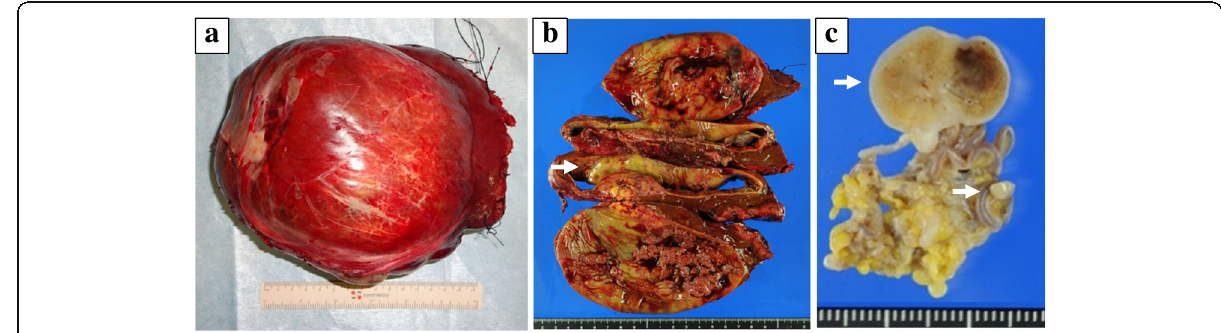
Fig. 3 Gross findings of specimens. a The hepatic tumor represents a massive cystic tumor containing hemorrhagic fluid and measuring 18×15 cm. b The cut surfaces of the tumor show a mucinous or hemorrhagic, brownish or yellowish multinodular tumor in the extracystic wall area ( white arrow ). c The cut surfaces of the omental tumors indicate multiple solid, brownish, nodular tumors measuring 2.1×1.3 and 0.3×0.3 cm ( white arrows )